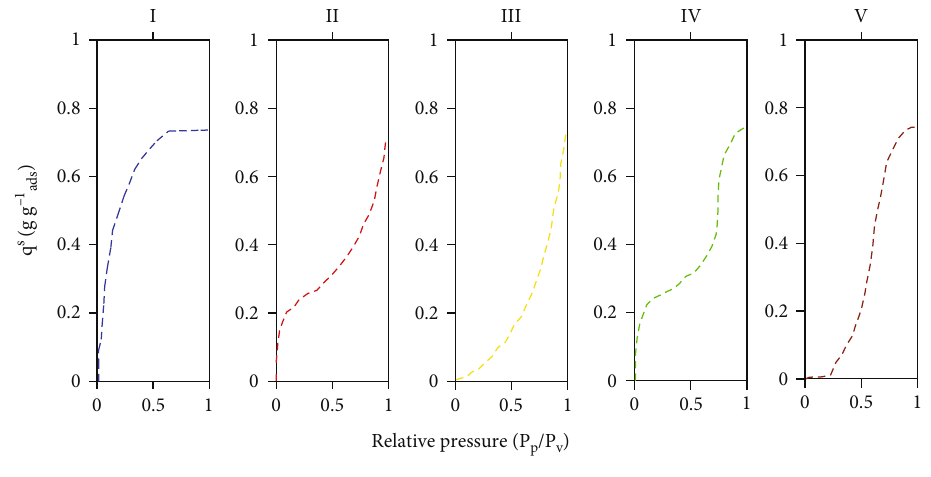
Figure 2: Adsorption